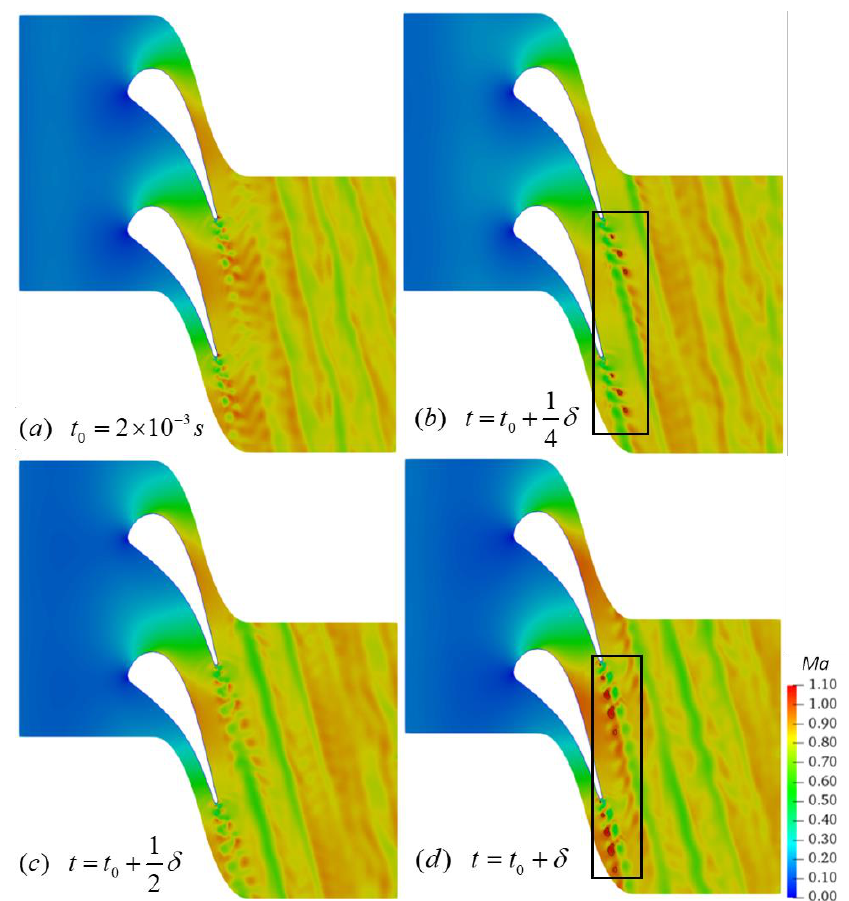
Figure 9. Distribution of instantaneous isentropic Mach number at different times within one period δ = 2 π / ω = 1 ms ; the black line represents the Ma=1).